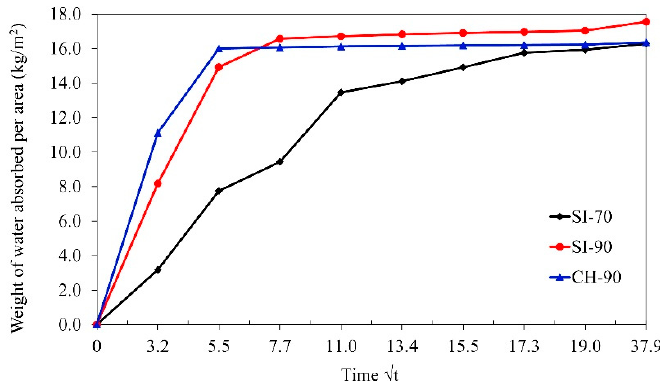
Figure 3. Capillary water absorption curves of the three injection grouts.